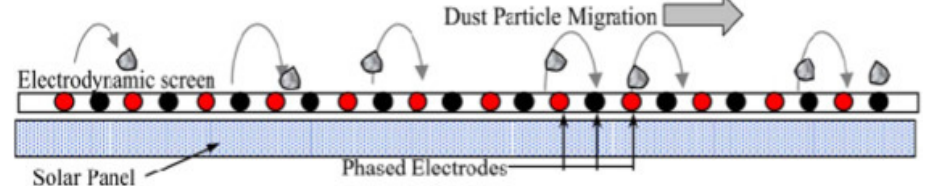
Figure 32. Working concept of EDS [142].